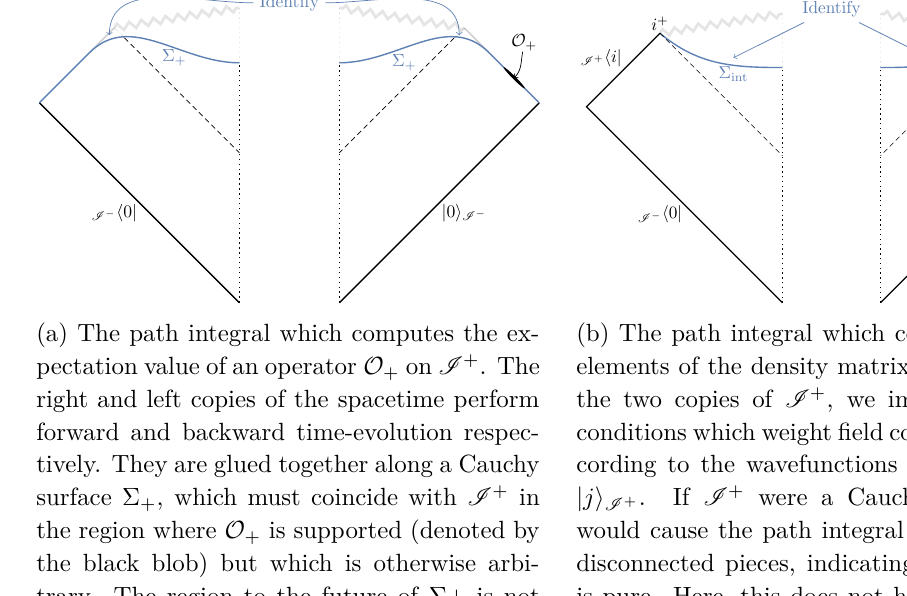
surface Σ + , which must coincide with I + in the region where O + is supported (denoted by the black blob) but which is otherwise arbi- trary. The region to the future of Σ+ is not part of the spacetime on which our path inte- gral is performed. Figure 5. Path integrals computing (a) the expectation value of an operator at I + and (b) components of the density matrix on I +